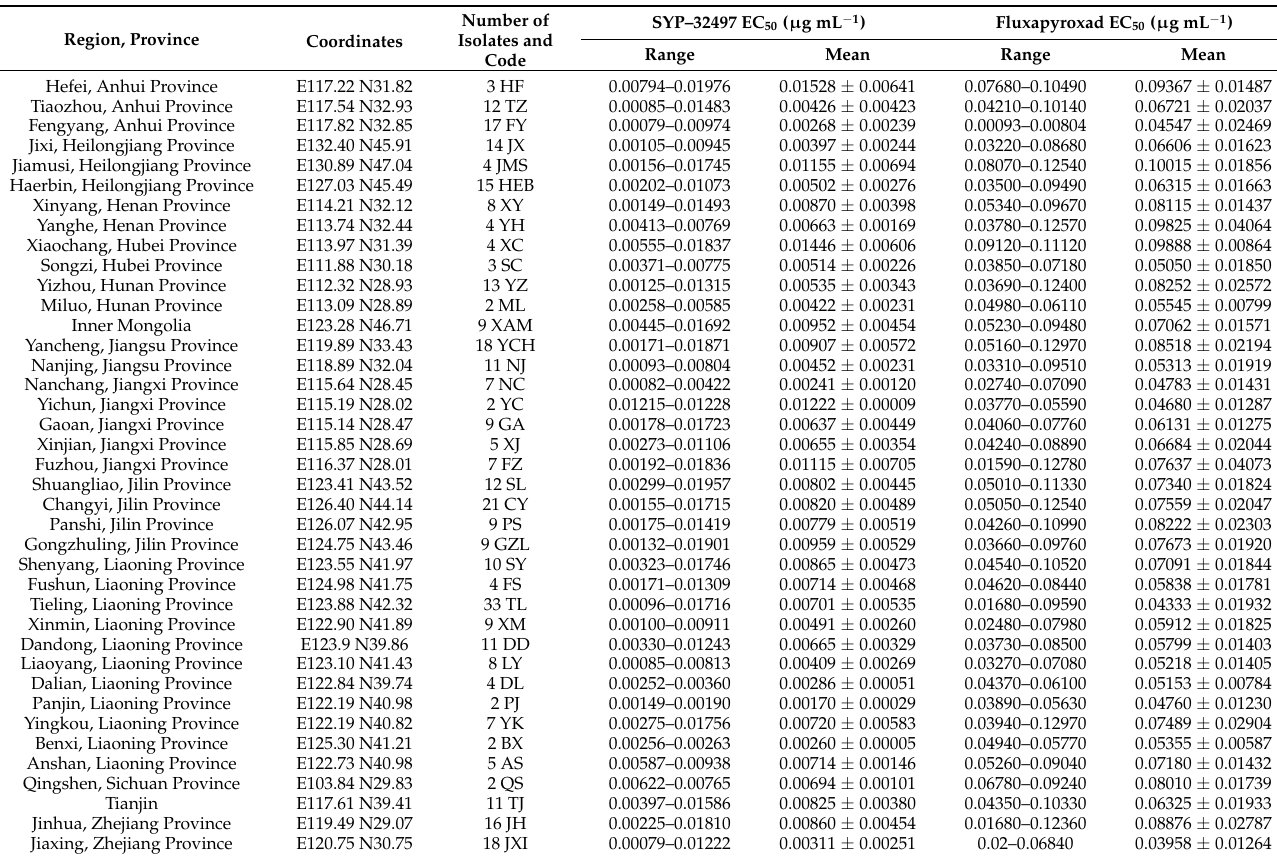
Table 1. Sensitivity of SYP-32497 and fluxapyroxad to R. solani in